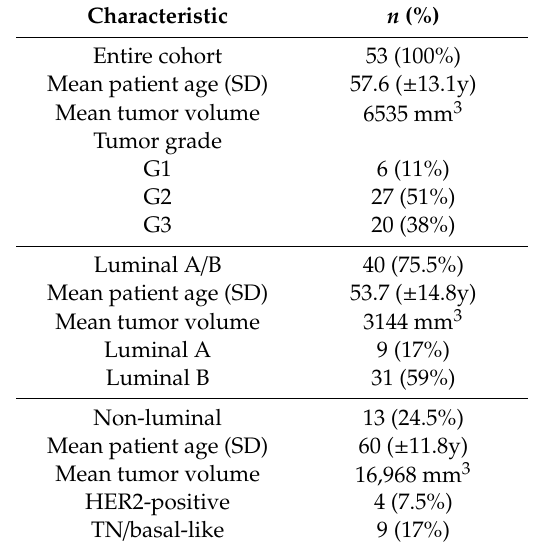
Table 2. Clinical and histopathological properties of participants ( n = 53). Characteristic